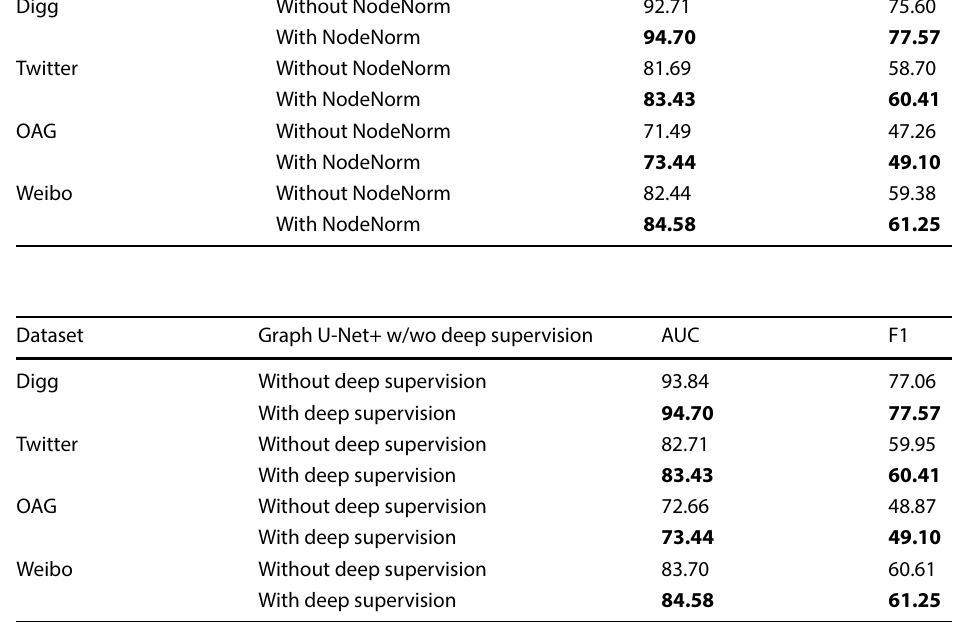
Table 7 Social behavior prediction performance of graph U-Net+ with or without NodeNorm layer on AUC and